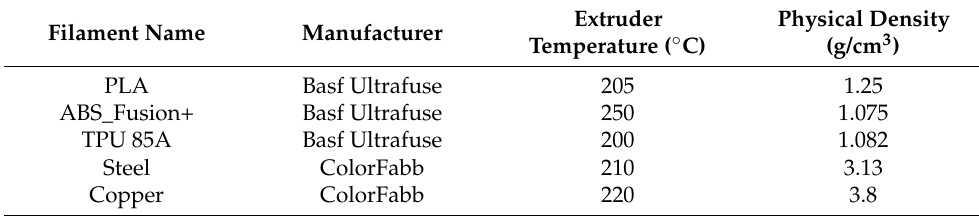
Table 1. Filaments used in the FDM